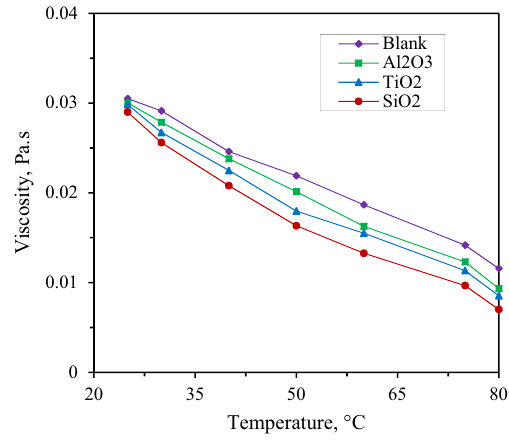
Fig. 11 Effect of nanoparticles on oil viscosity at different tempera- tures at a concentration of 0.05